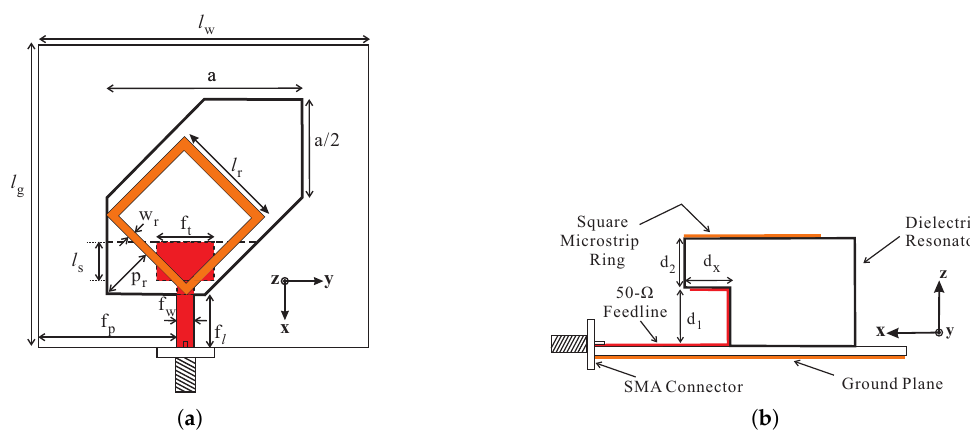
Figure 1. Geometry of the proposed hybrid dielectric resonator antenna (DRA): ( a ) Top view; ( b ) Side view. Dimensions in mm: ( a = 35.4, d 1 = 13, d 2 = 11, d x = 9.5, f l = 17.3, f p = 35, f t = 10.5, f w = 3, l g = 70, l r = 20.5, l s = 8, l w = 80, w r = 1.5, p r =